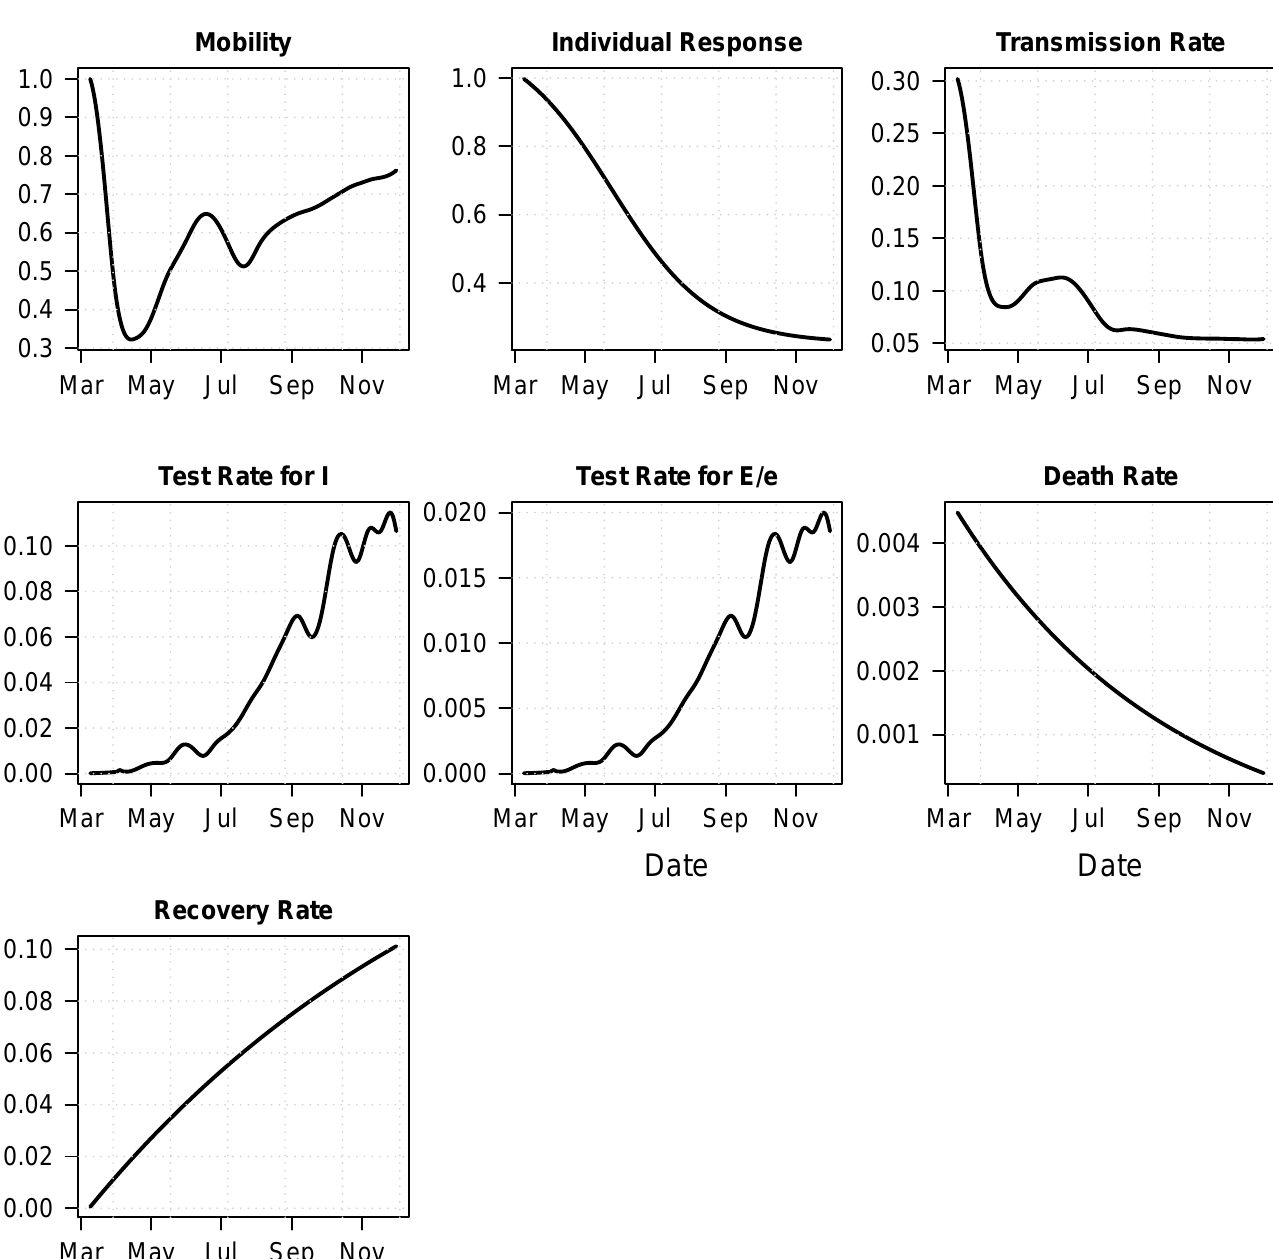
Figure 4. The posterior mean of the time-dependent parameters from the SEIR model for